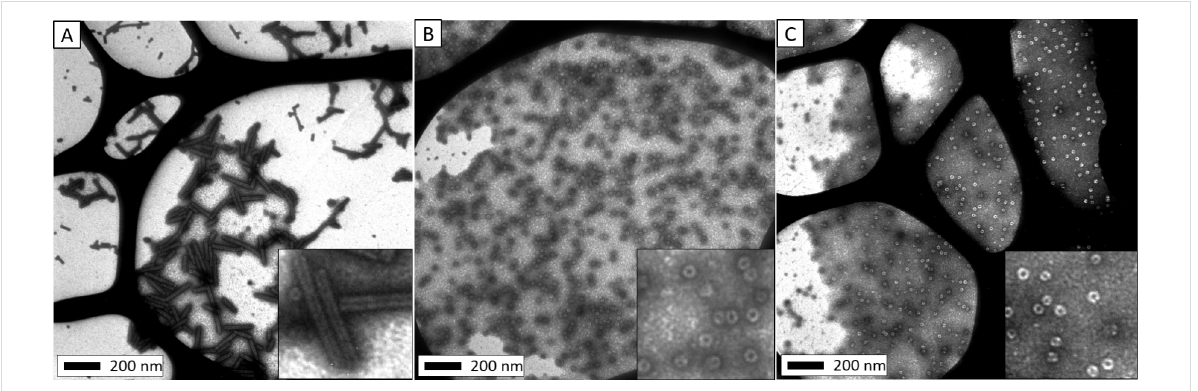
Figure 4: TEM images comparing TMV-cp particles assembled in 5.0 mol % ethanol at different pH values. (A) pH 5.0; (B) pH 6.8; (C) pH 7.5.